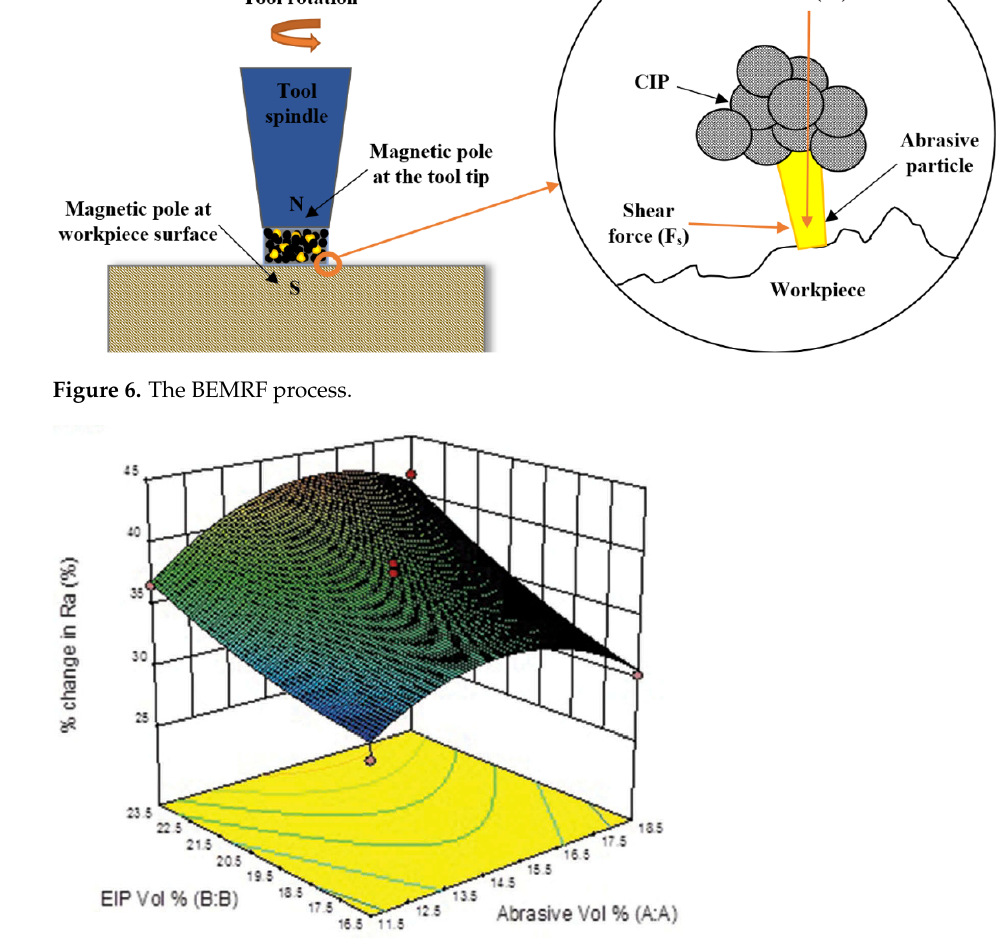
Figure 7. The effect of process parameters in the BEMRF process [19].